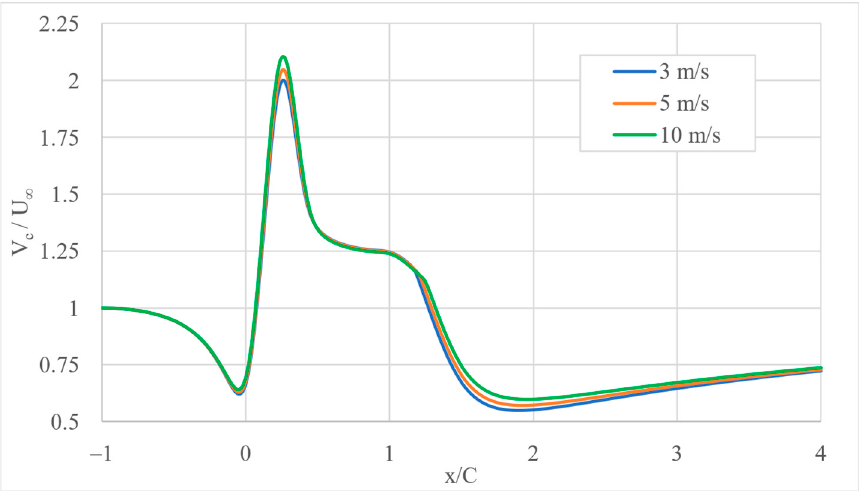
Figure 12. Centre line velocity change along the augmentation system at different wind speeds (gap = 30 cm, +5° pitch angle).